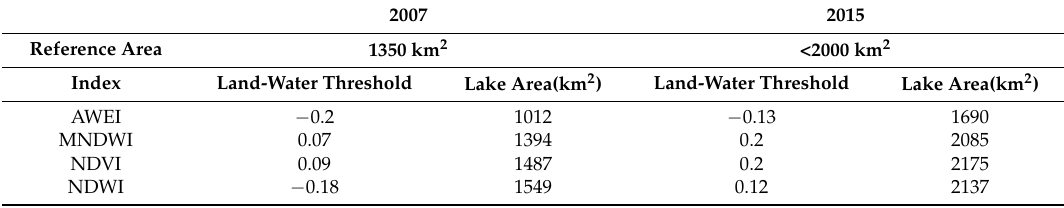
Table 4. Estimated area from each index and their respective threshold for the test